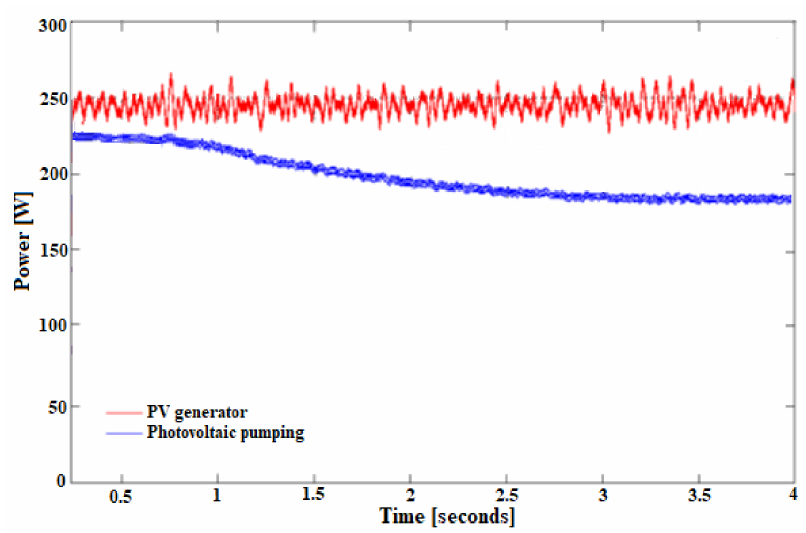
Figure 22. The performances of the PV pumping system in the case with